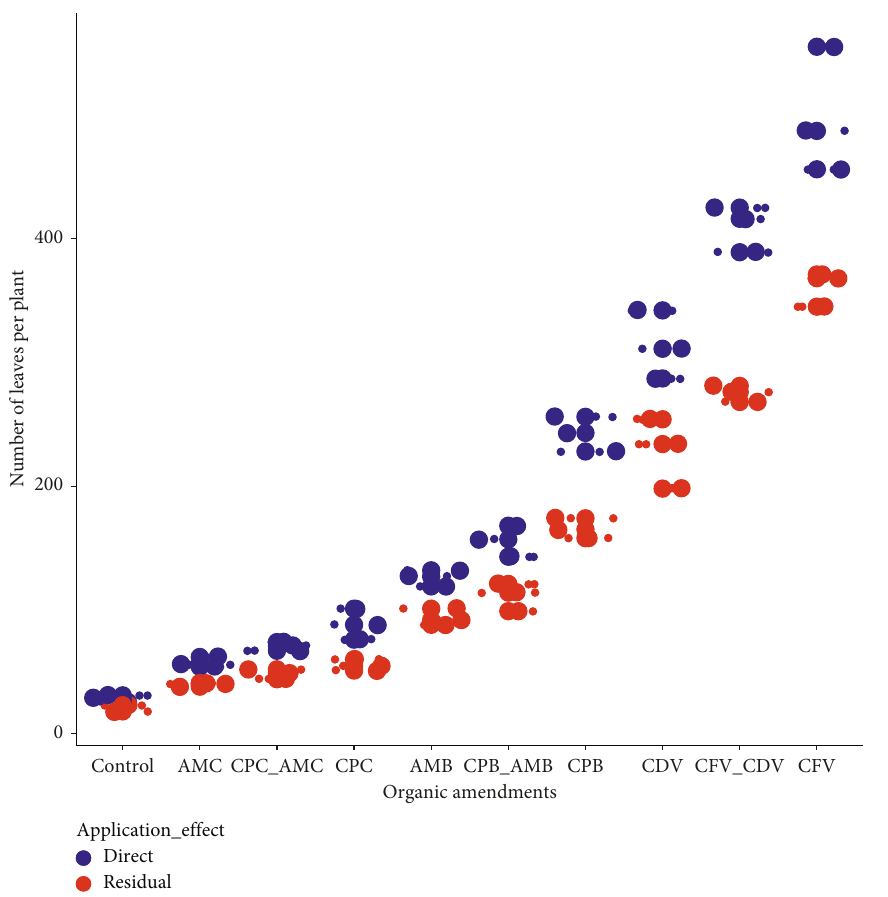
Figure 4: The influence of organic amendments on hot pepper leaf